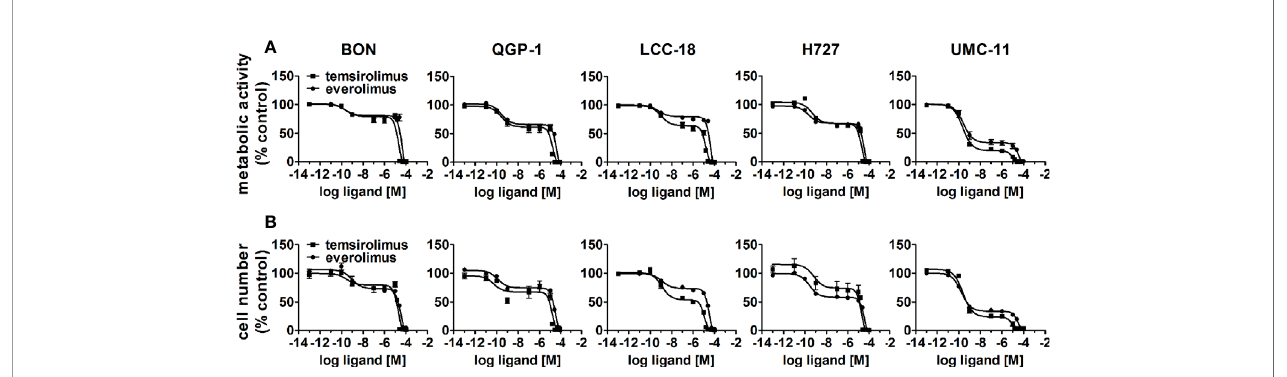
FIGURE 1 | Treatment with mTOR inhibitors results in a biphasic inhibition of NEN cell viability. NEN cell lines were treated with increasing concentrations of temsirolimus or everolimus (0.1 pM to 100 µM), incubated for 96 h and analyzed for metabolic activity (A) and cell number (B) . Data represent mean ± S.E.M. (n=3).